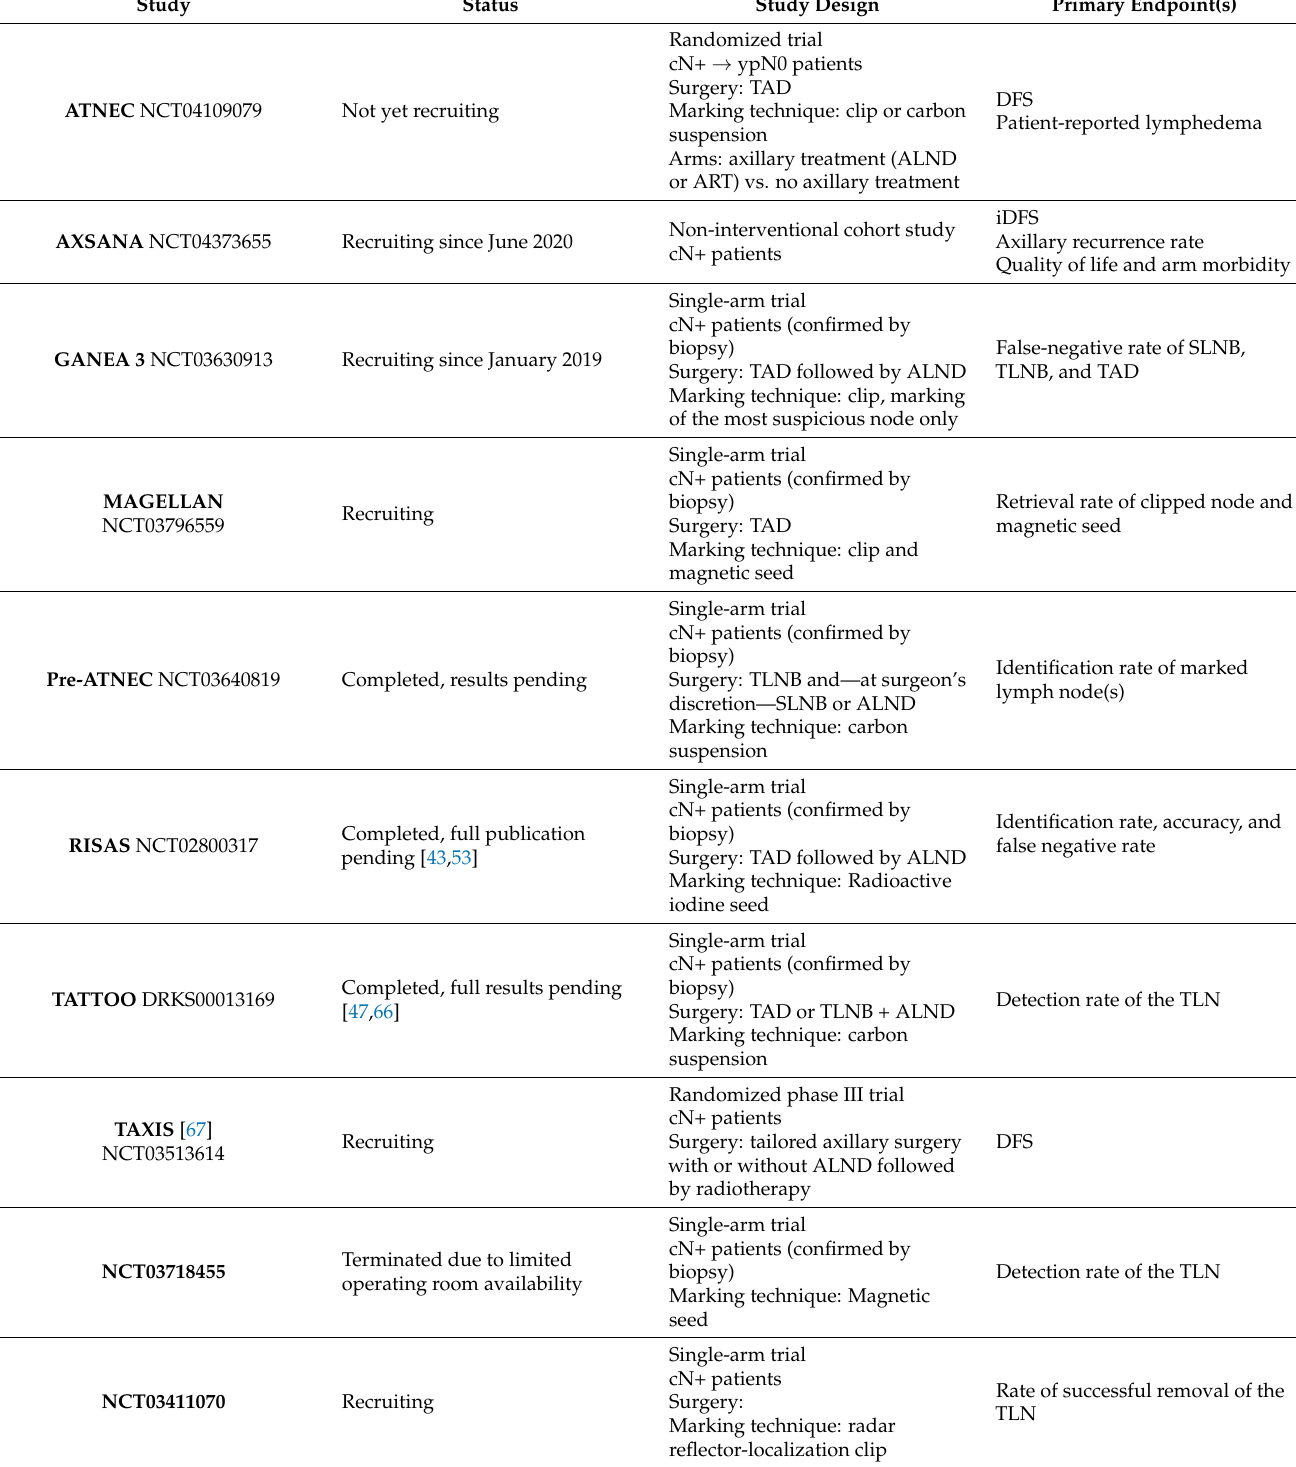
Table 9. Current trials investigating de-escalation of surgical treatment in cN+ patients undergoing neoadjuvant therapy.